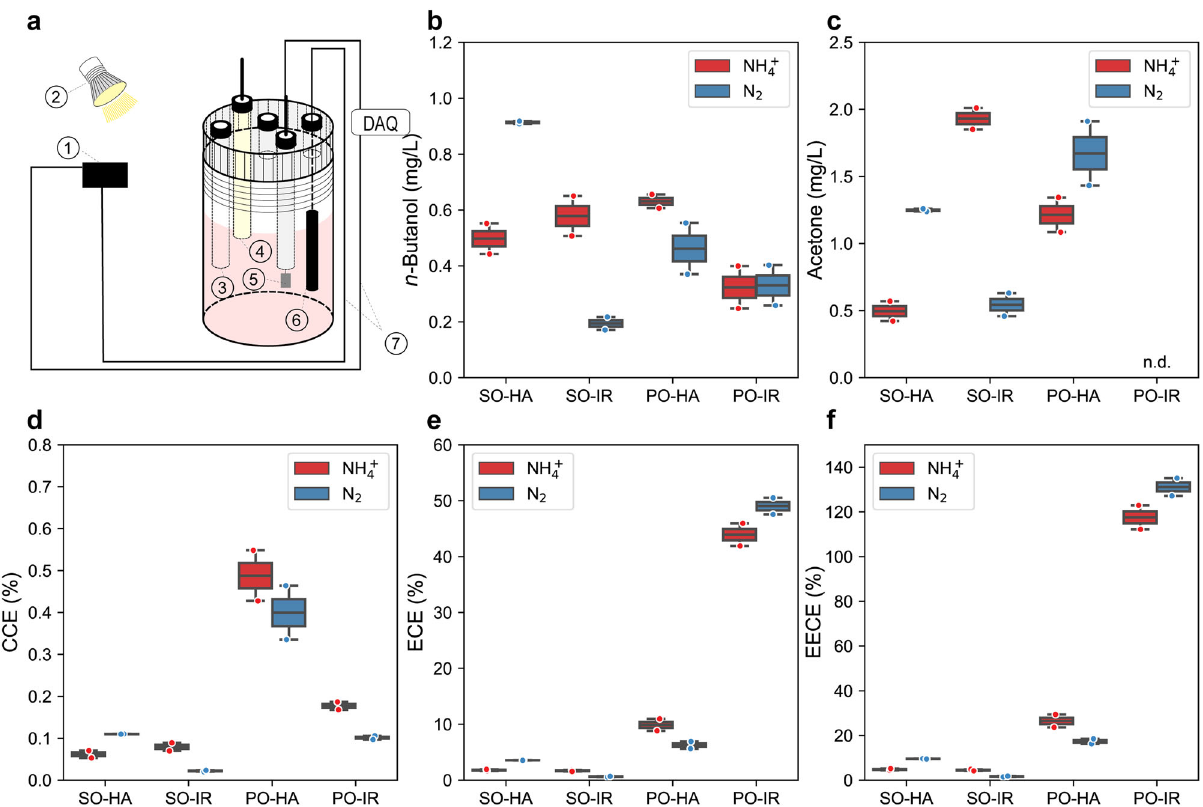
Fig. 8 Three-electrodes con fi gured sealed type bioelectrochemical cell (BEC), n -butanol production, acetone production, carbon conversion ef fi ciency, electron conversion ef fi ciency, and electrical energy conversion ef fi ciency (EECE) towards n -butanol by the nitrogenase double mutant with the 5-gene cassette under photoelectroautotrophy. Under photoelectroautotrophic conditions, TIE-1 gains electrons from a poised electrode, using light as an energy source and carbon dioxide as a carbon source. For all the platforms, either ammonium (NH 4 + ) or dinitrogen gas (N 2 ) was supplied. a Schematic set up of BEC platform. platform set up: 1- electricity source 2-light source, 3- Purge inlet, 4- Reference electrode (Ag/AgCl in 3 M KCl), 5- Counter electrode (Pt foil, 5 cm 2 ), 6- Working electrode (Graphite rod, 3.2 cm 2 ), 7- electrical wire DAQ- Data acquisition); b n -butanol production; c acetone production; d carbon conversion ef fi ciency (CCE) towards n -butanol; e electron conversion ef fi ciency (ECE) towards n -butanol; f electrical energy conversion ef fi ciency (EECE) towards n -butanol. PO potentiostat, IR infrared light, HA halogen light, SO solar panel. Data are from n = 2 of independent